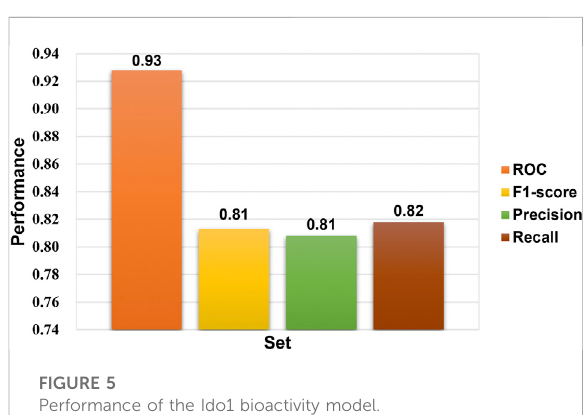
TABLE 2 IDO1 inhibitory activities of synthesized compounds.